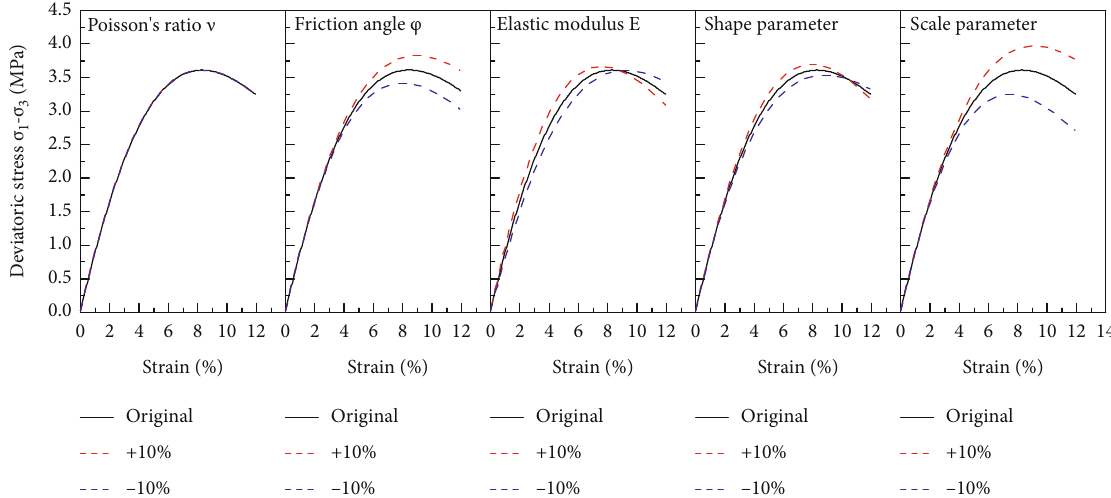
Figure 8: Comparison of the in fl uence of a 10% increase and 10% decrease in each parameter on the calculated model curve (frozen sand).